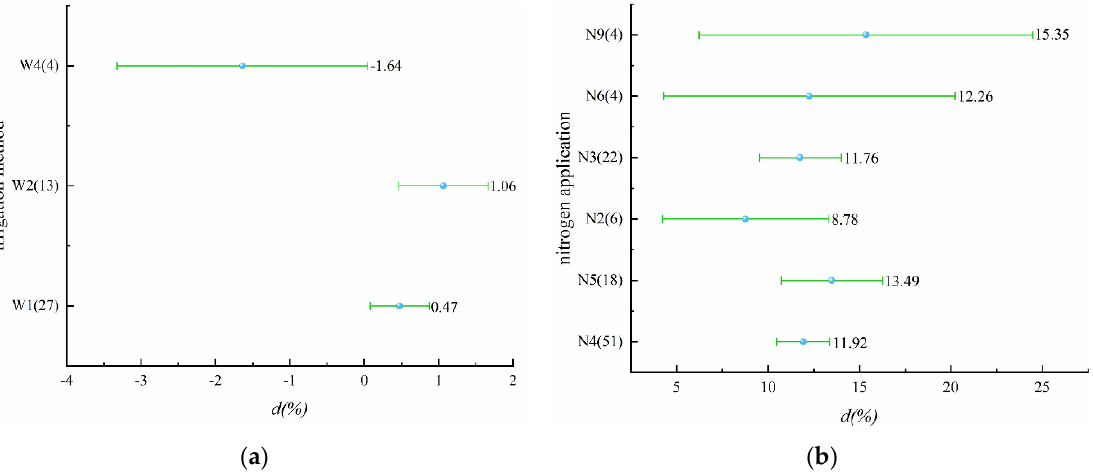
Figure 3. ( a ) Effect of different irrigation schedules on nitrogen use efficiency ( p = 0.01682); ( b ) effect of different nitrogen application levels on nitrogen use efficiency ( p = 0.03588).